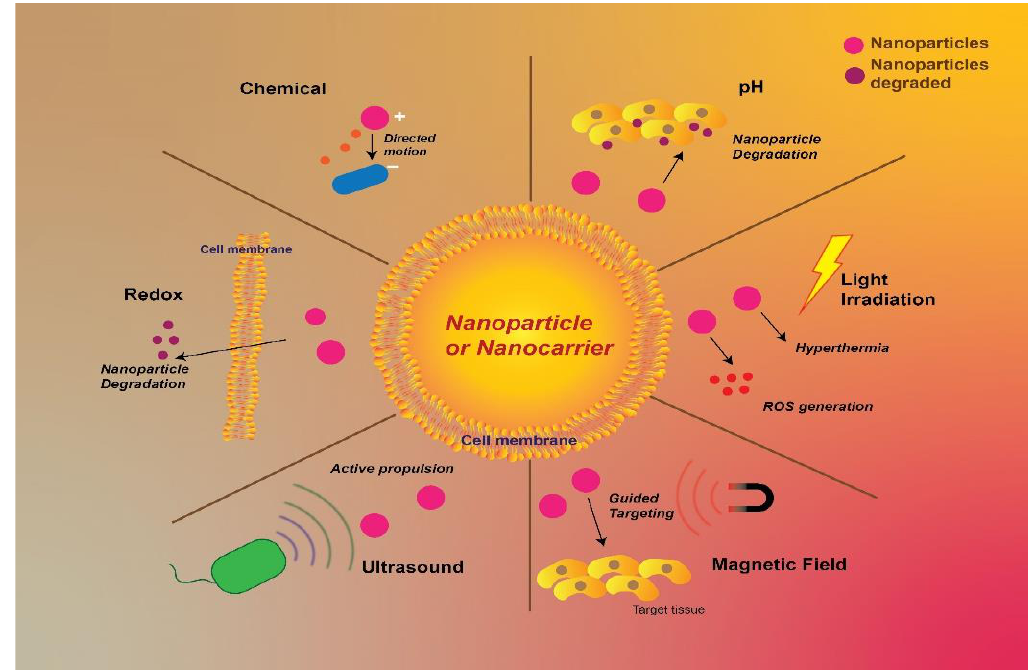
Figure 4. Different stimuli-responsive nanoparticles. Overexposure to the specific stimulus, would convert these stimuli-responsive systems into controlled drug-releasing systems or would also enhance the uptake or penetration of the drug in the tumor microenvironment. The engineering of the stimuli-sensitive drug delivery systems, mainly relies on the specific biochemical contents of the affected areas and thus leads to specific temporal and spatial drug delivery [194–196]. Some recently reported stimuli-based nanoformulations and their outcome are displayed in Table